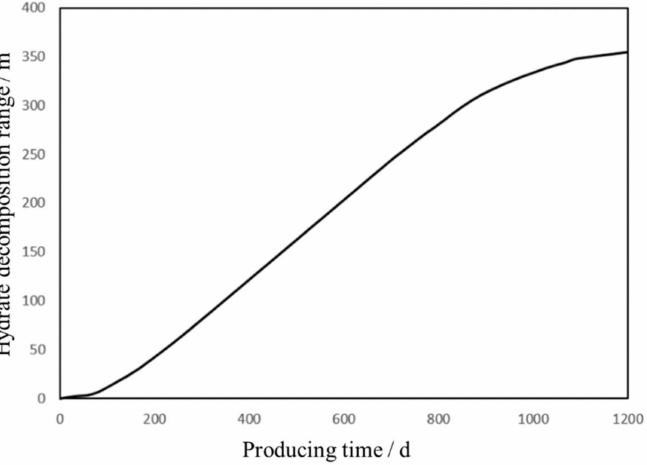
Figure 4. Relationship between the depressurization duration and decomposition range of